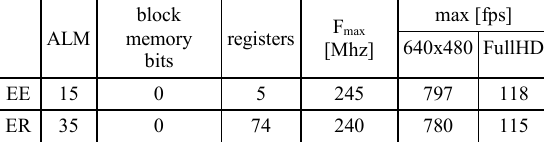
Tab. 1. Synthesis results in FPGA Cyclone